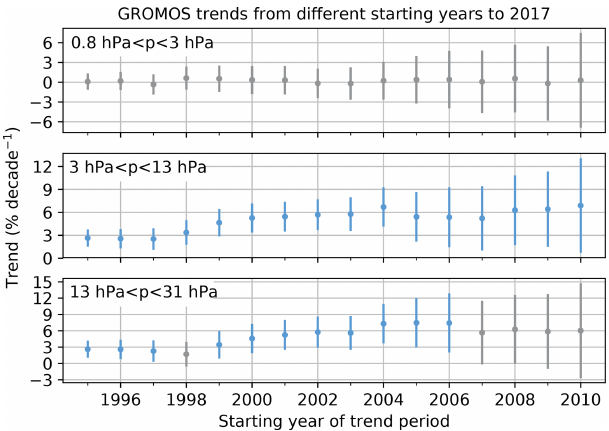
Figure 9. GROMOS trends averaged over three altitude ranges starting in different years, all ending in December 2017. The error bars show the 2 σ uncertainties. Trend estimates that are not signif- icantly different from zero at a 95% confidence interval are shown in